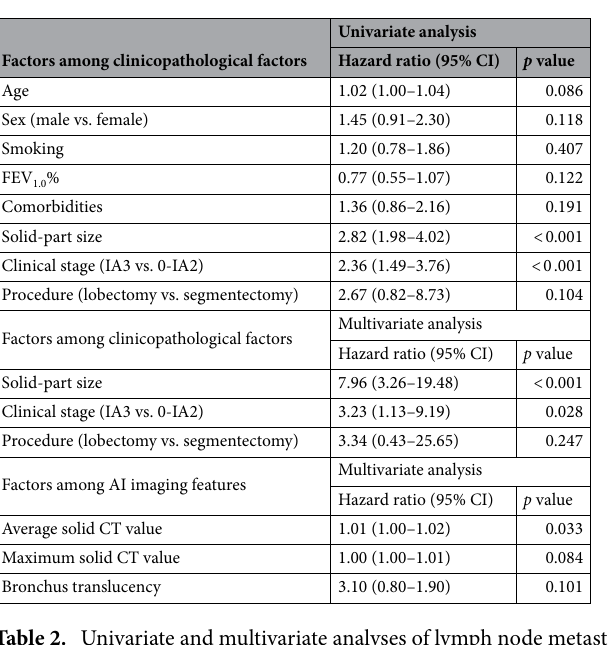
Table 2. Univariate and multivariate analyses of lymph node metastasis in the derivation cohort. CI confidence interval; FEV forced expiratory volume; AI artificial intelligence; CT computed tomography.